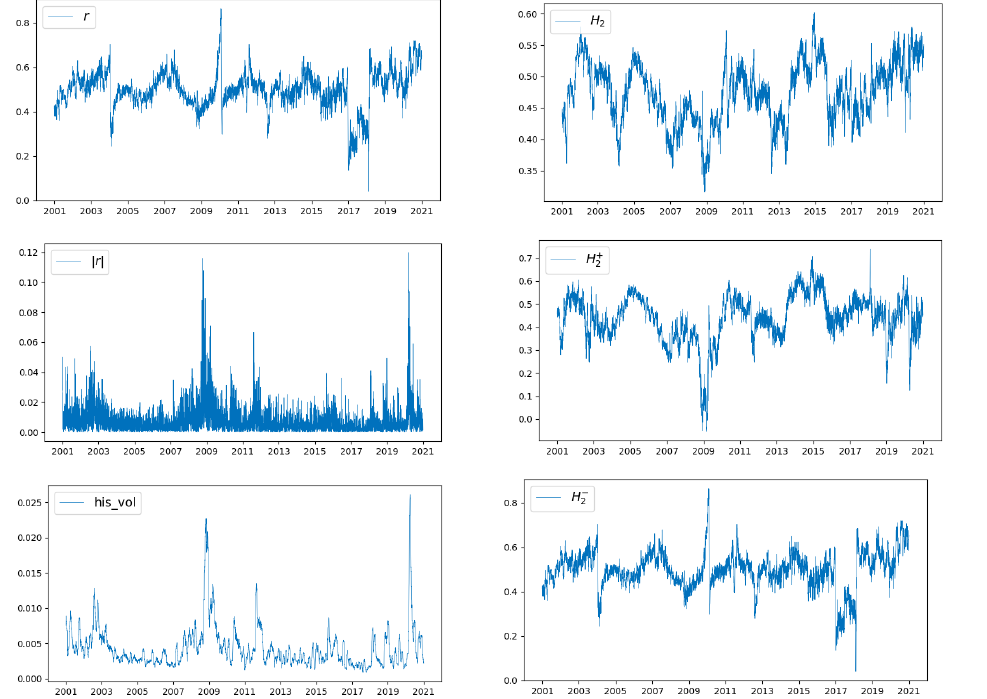
Figure 2. The graph of time-series data for daily return, absolute return, historical volatility and overall, up-trend, down-trend Hurst exponents of S&P500 index data from 2000 to